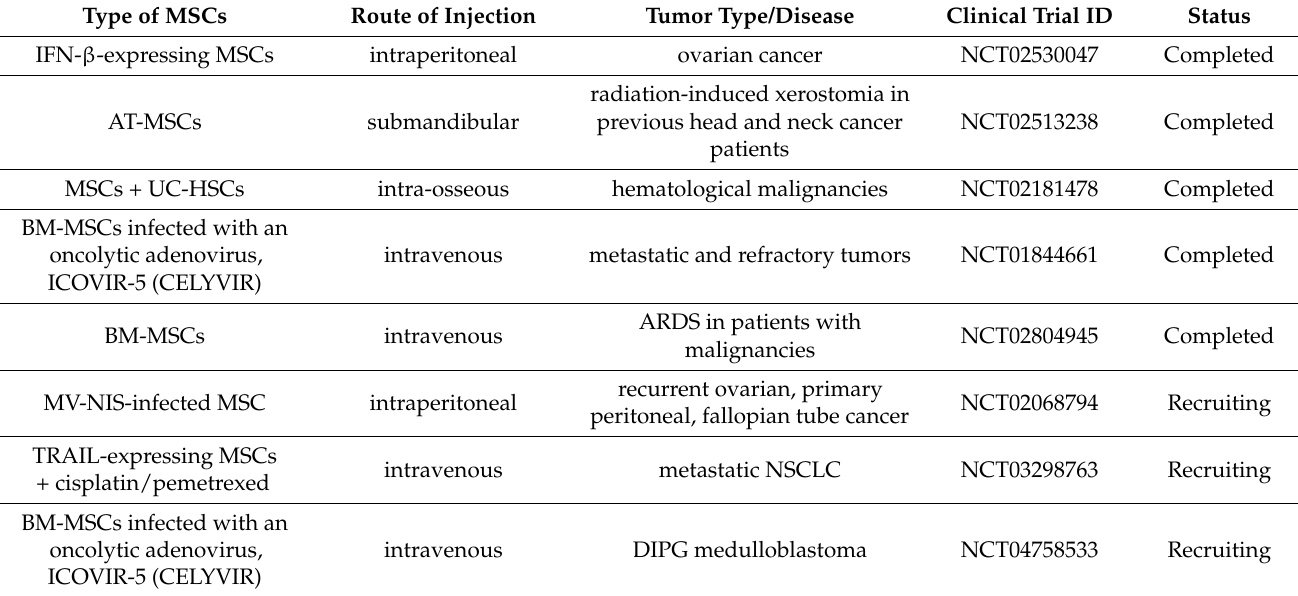
Table 1. Clinical studies using MSC-based therapies for cancer